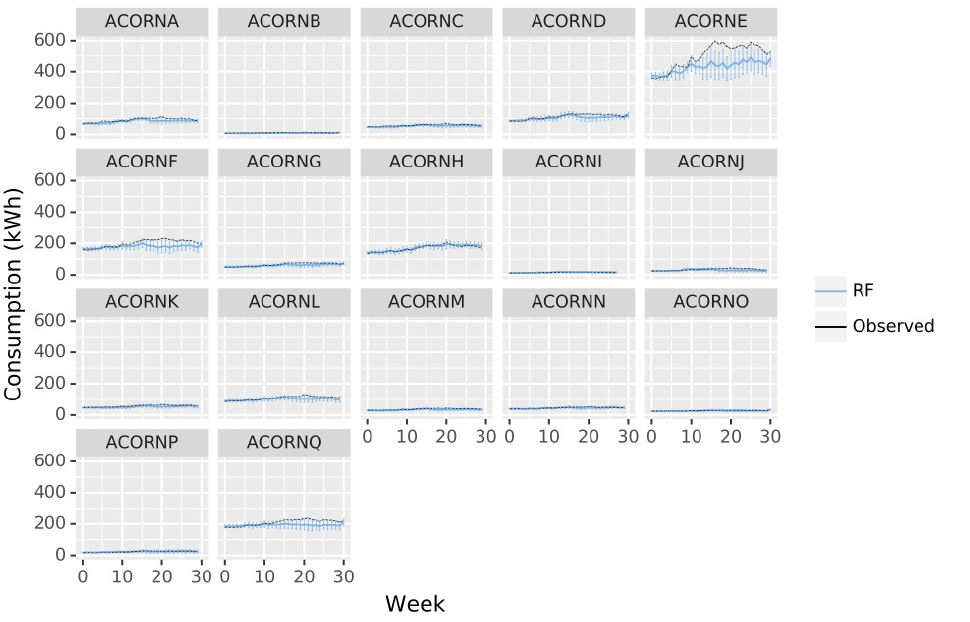
Figure 5. Energy consumption observations (kWh, black line) across the latest 270 days of data against RF mean predictions by week of the year (average 24 h and 7 days observations) for each ACORN group (blue line). Represented observed data are average values. Error bars represent predictions square deviation of the 24 h and 7 days average